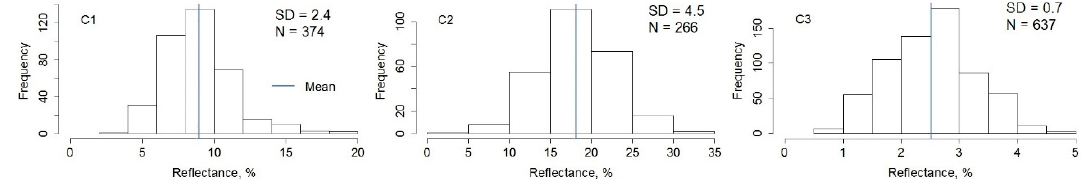
Figure 5. Left to right: C1, C2, and C3 spectral reflectance (in %) histograms for single returns of the canopy ( > 10 m above ground) of the established Lodgpole Pine plot (Plot 1) of 11.3 m